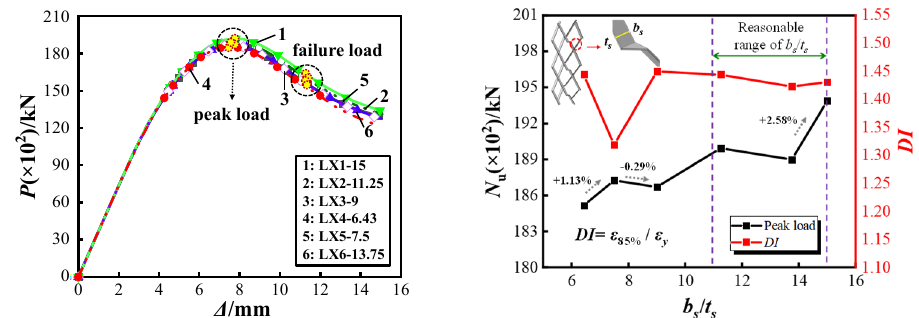
Figure 19. Load–displacement curves for different width to thickness ratios of spiral ribs.